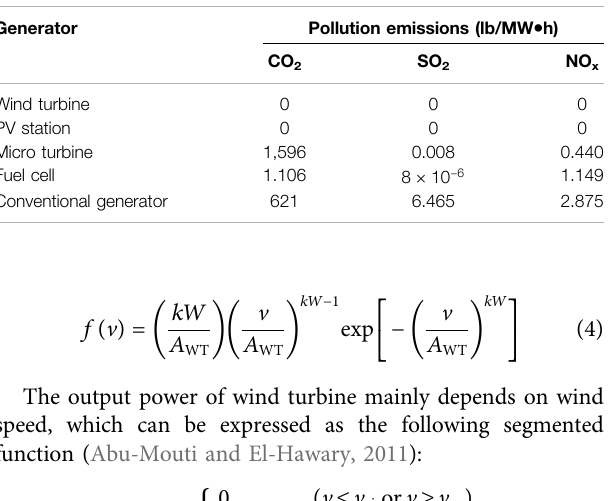
TABLE 1 | Five types of power generation